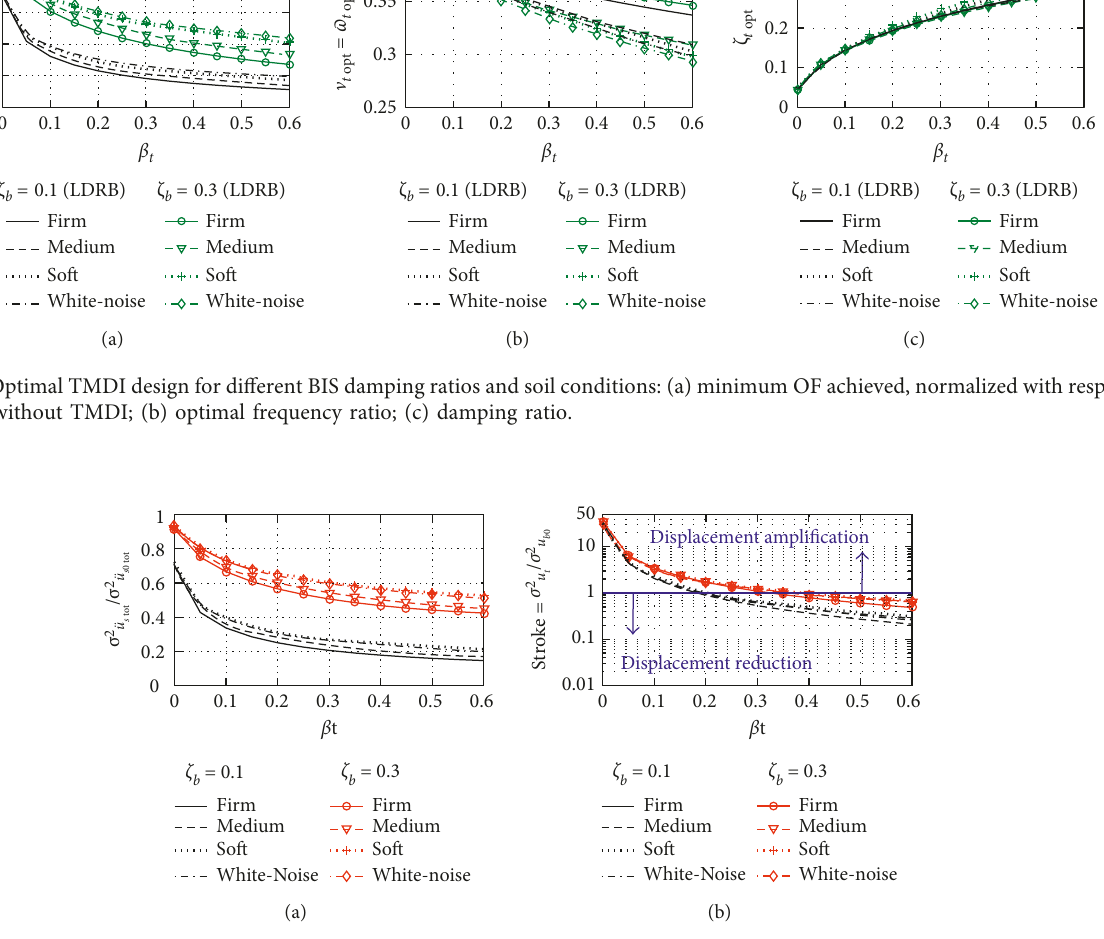
Figure 11: Optimal TMDI design for different BIS damping ratios and soil conditions: (a) normalized total acceleration variance and (b) normalized TMDI displacement variance, representative of the TMDI